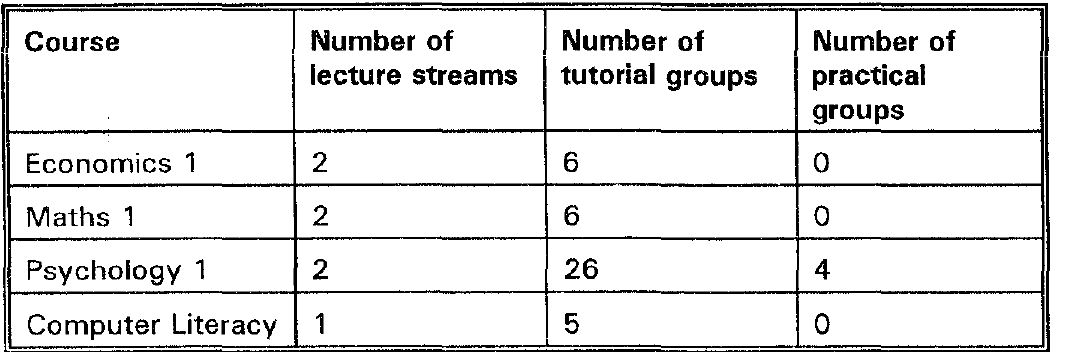
Table 3. Specimen first year curriculum in Arts